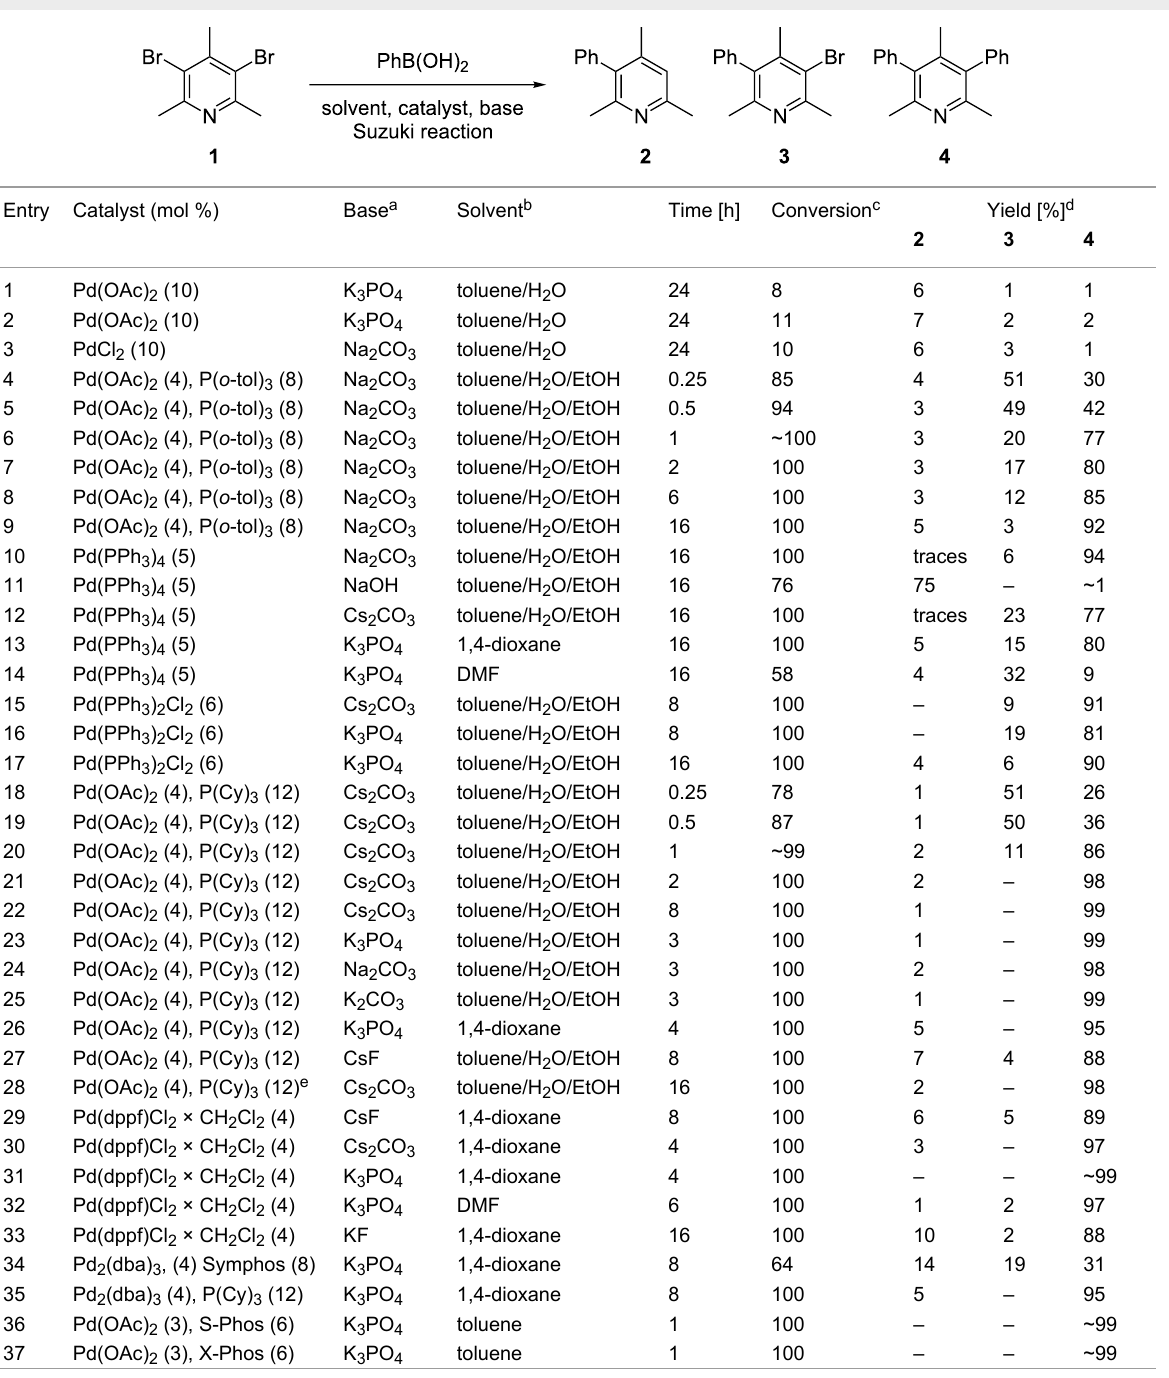
Table 1: Optimization of the reaction